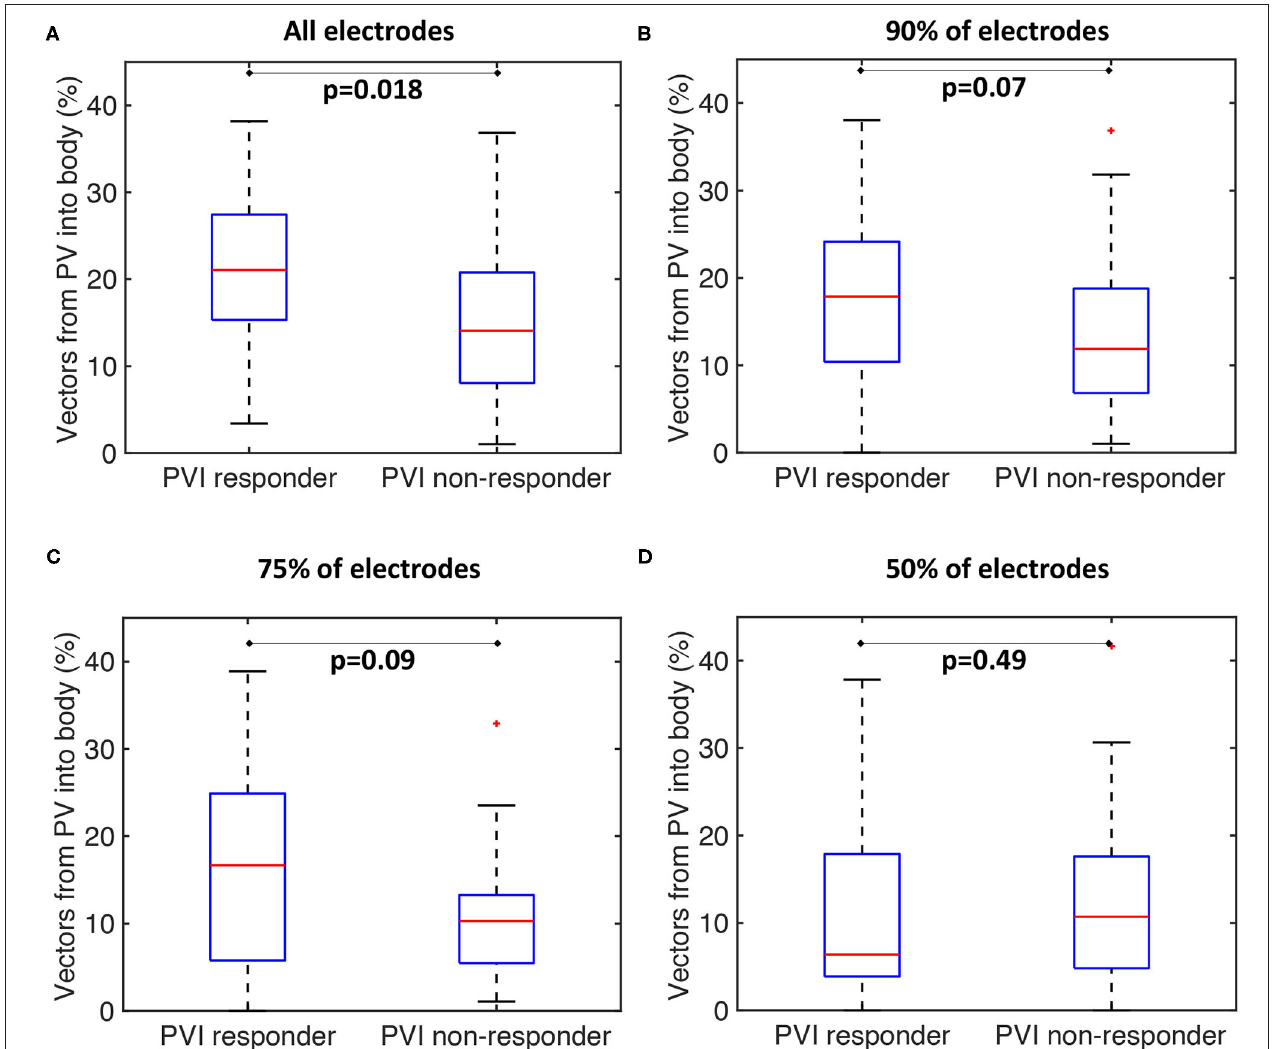
FIGURE 11 | Effects of basket contact on preferential pathways. Effects of poor contact on preferential pathway analysis. PV activation flow metrics are shown for cases with 10–50% of electrodes removed. (A) All electrodes: median 21.1 vs. 14.1%, p = 0.018, Wilcoxon signed rankmedian. (B) 90% of electrodes included: 17.9 vs. 11.9%, p = 0.07. (C) 75% of electrodes included: 16.7 vs. 10.3%, p = 0.09. (D) 50% of electrodes included: 6.4 vs. 10.7%, p =